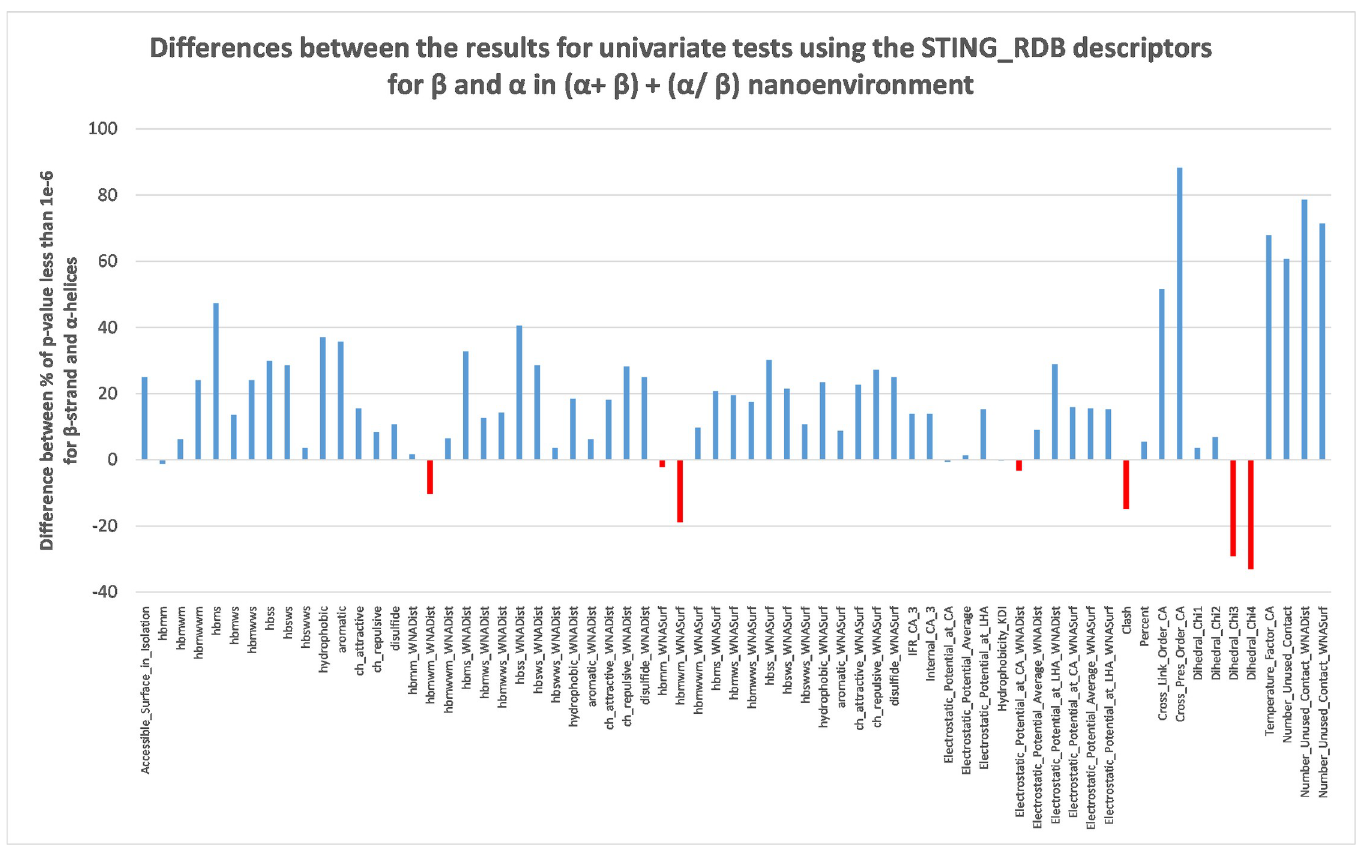
Fig 2. Differences observed in percentwise coverage for p-values being less than 1e-6 for univariate test results using the STING_RDB descriptors for β -sheets in ( α + β )+( α / β ) protein types and for α -helices in ( α + β ) + ( α / β ) proteins nanoenvironment.